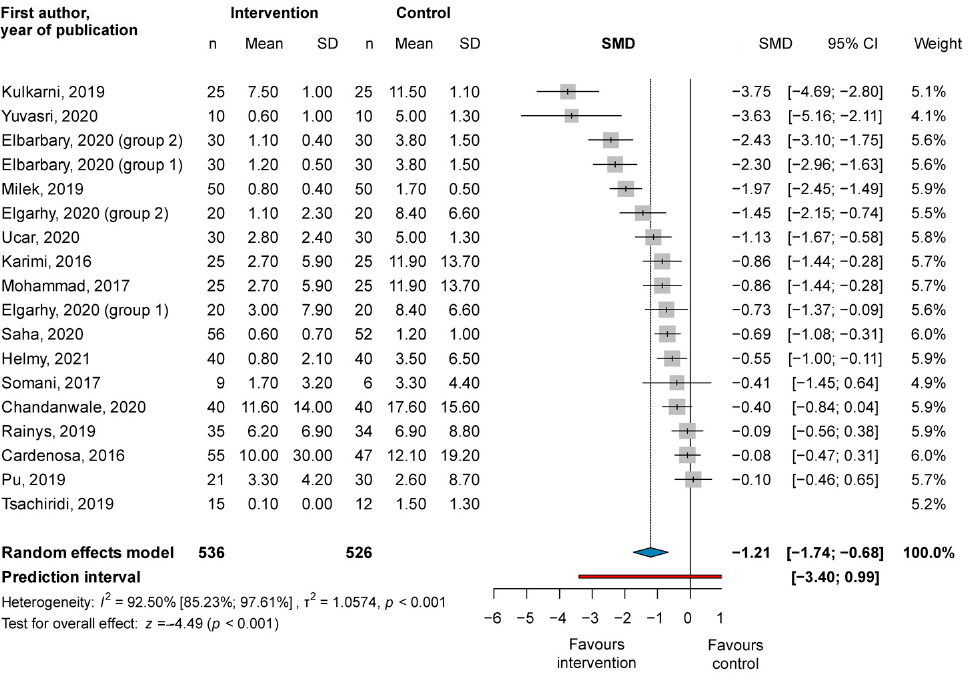
Table 2. Main conclusions of the studies assessing the secondary